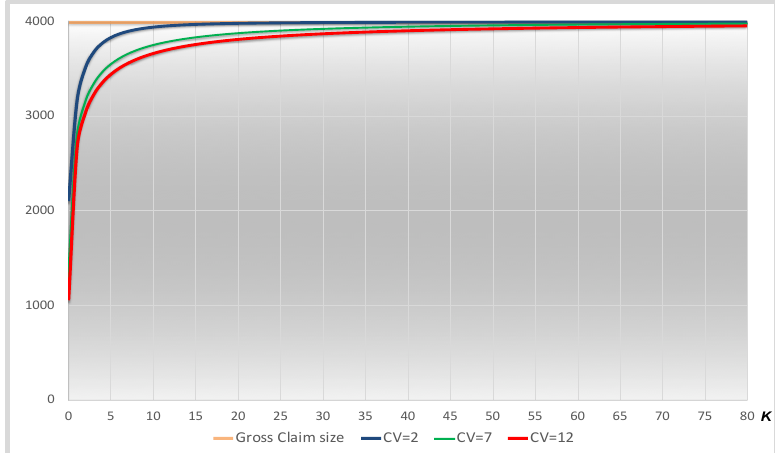
Figure 1. Expected single claim size m M for different c ˜